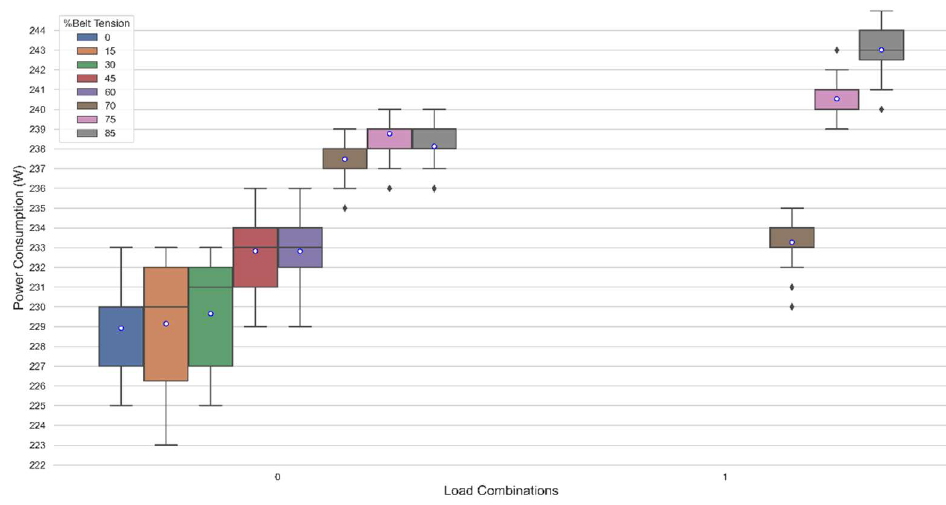
Figure 14. Data overlapping (misprediction).